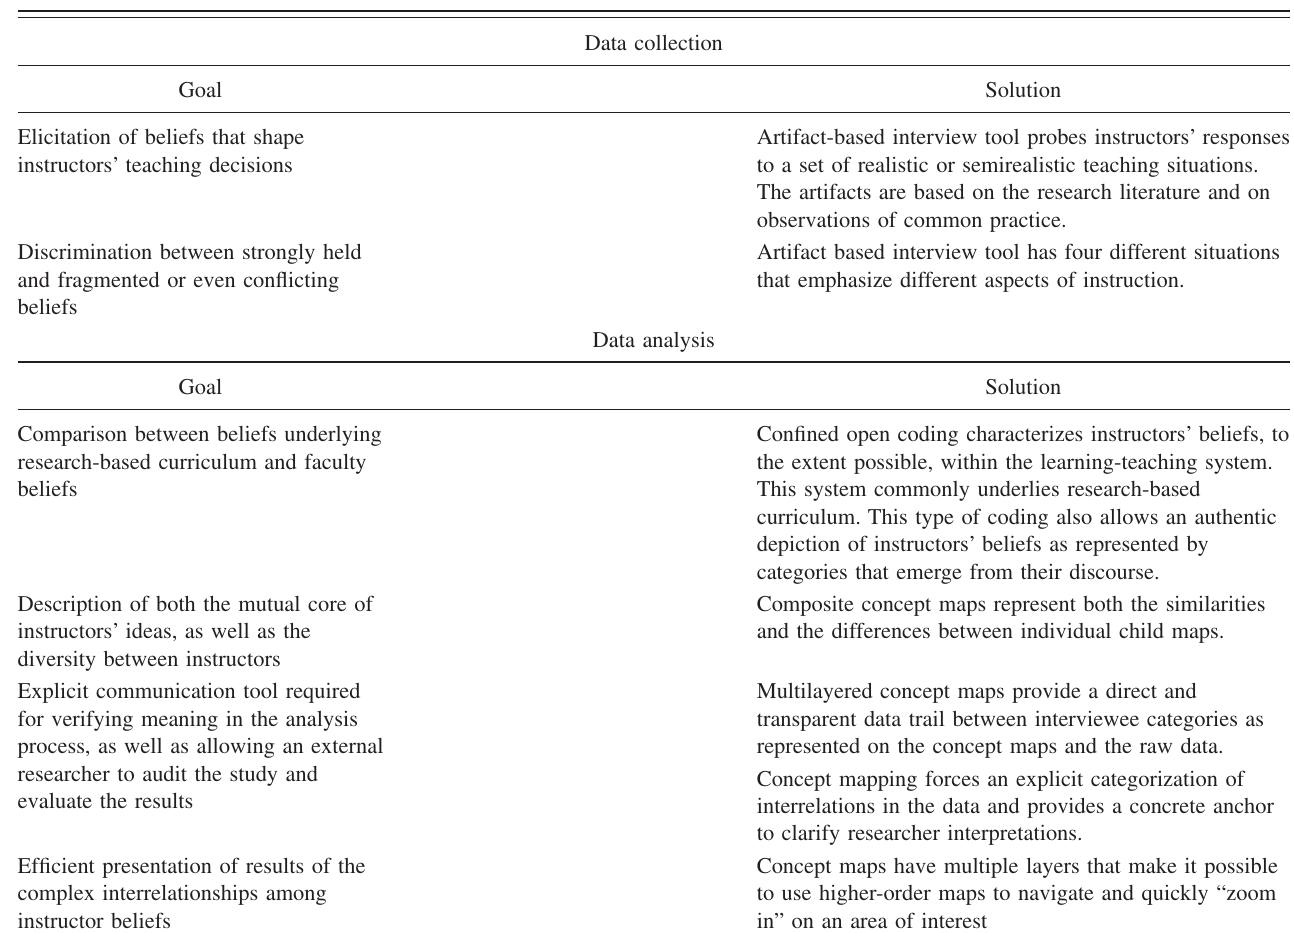
TABLE III. Summary of methodological goals and solutions described in this